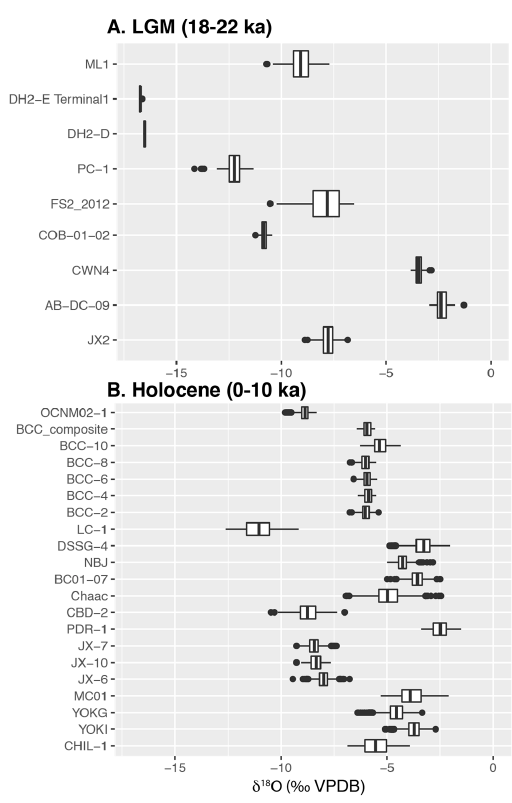
Figure 4. Box and whisker plots comparing ( A ) LGM (18-22 ka) and ( B ) Holocene (0-10 ka) values of δ 18 O spel . Records are arranged by latitude, with lower latitude records at the bottom of each panel. Center lines are median values and box hinges represent the first and third quantiles. Whiskers extend to the highest and lowest values with points plotted beyond the whiskers considered as outliers.